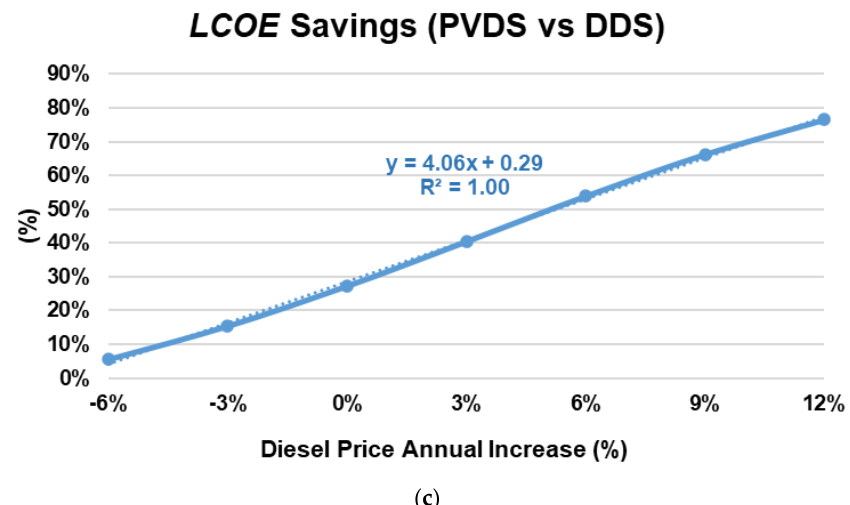
Figure 4. Profitability index ( a ), levelized cost of energy ( b ), and LCOE savings compared to the diesel-powered drying system ( c ) obtained for an annual variation in diesel fuel costs between −6% and +12%.